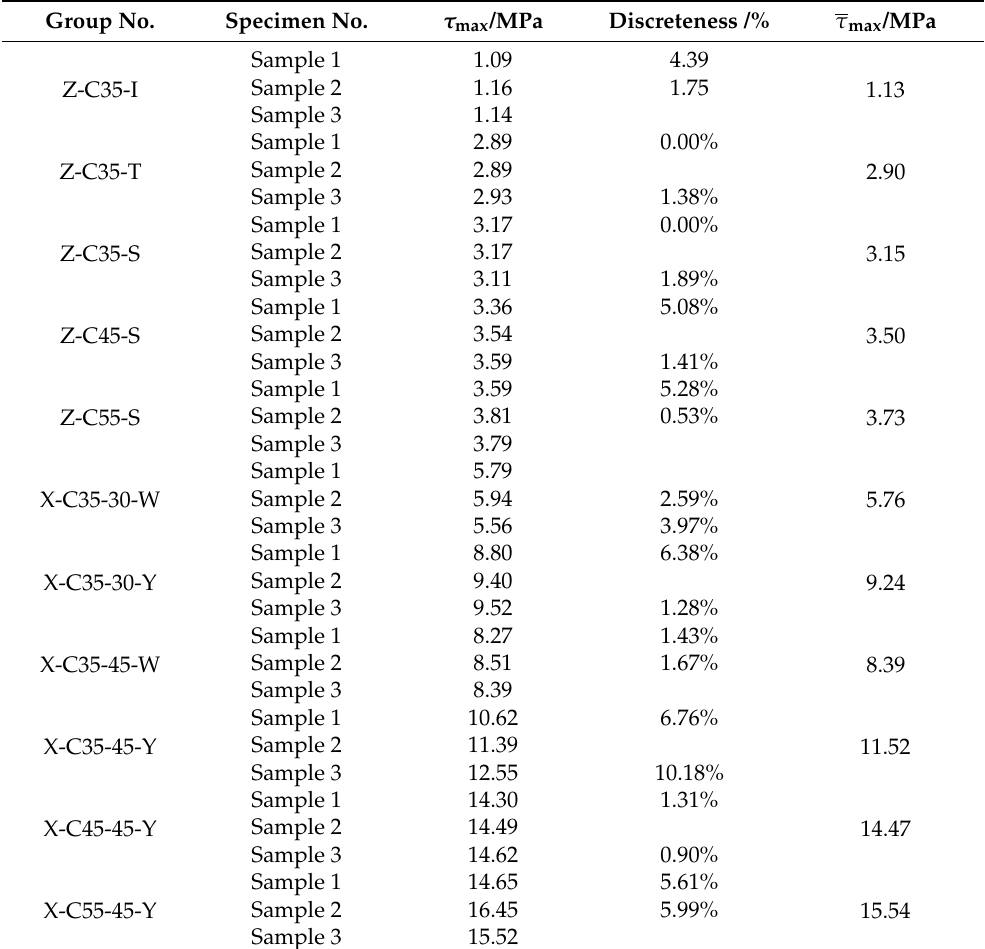
Table 5. Interfacial bond strength of each specimen. Group No. Specimen